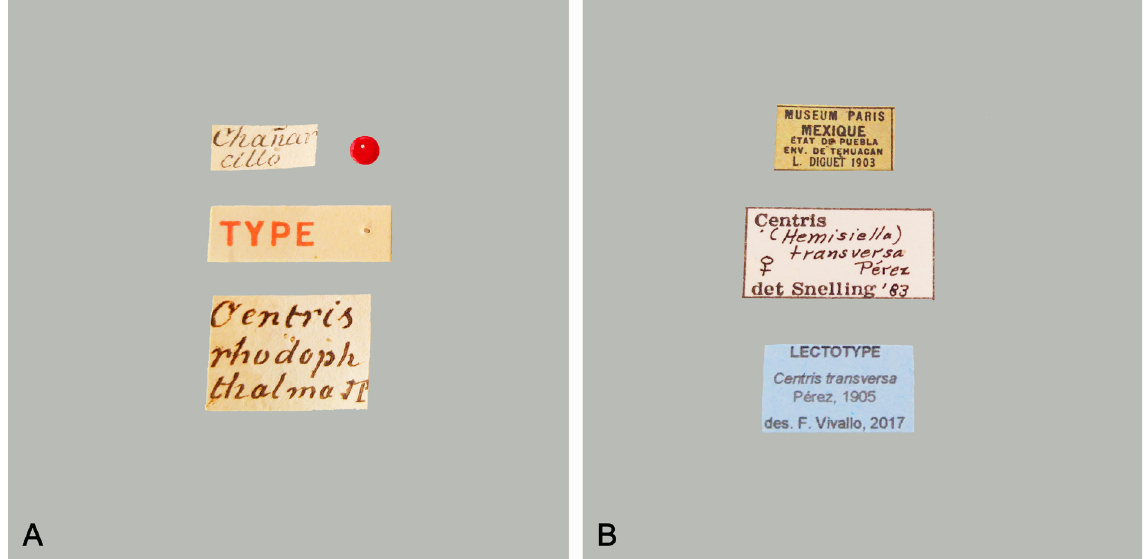
Fig. 4. Data labels. A . Centris rhodophthalma Pérez, 1911 (lectotype ♀︎). B . Centris transversa Pérez, 1905 (lectotype